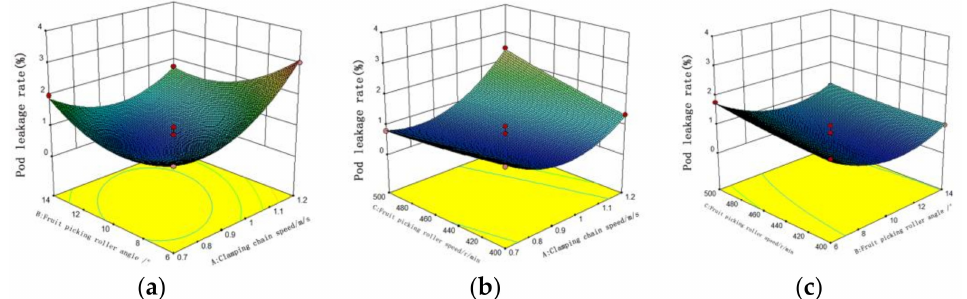
Figure 13. Response surface of the influence of factor interaction on miss picking rate. ( a ) Interaction between peanut picking roller angle and clamping chain speed; ( b ) Interaction between peanut picking roller speed and clamping chain speed; and ( c ) Interaction between peanut picking roller speed and picking roller